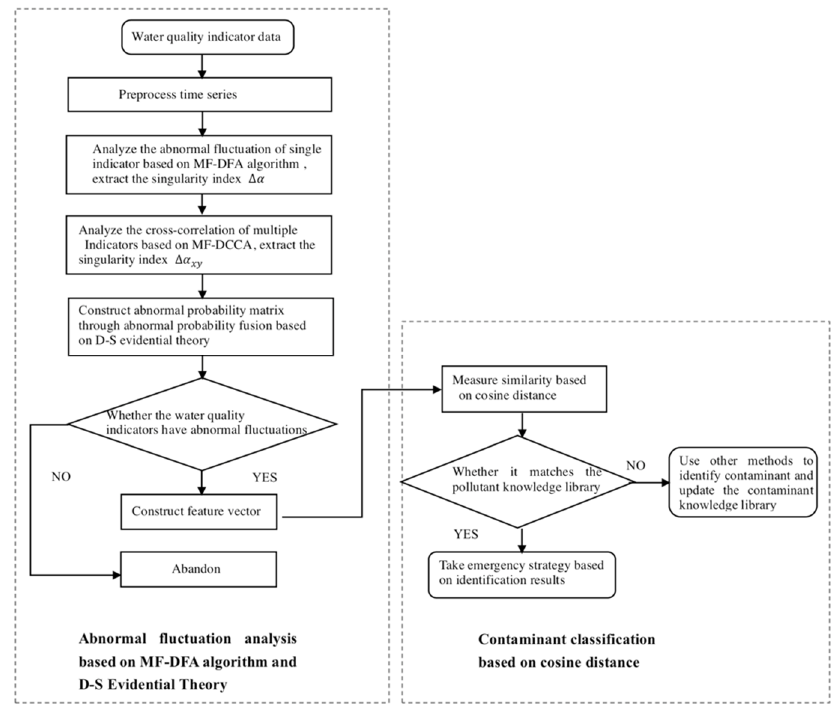
Figure 1. The workflow of the method.